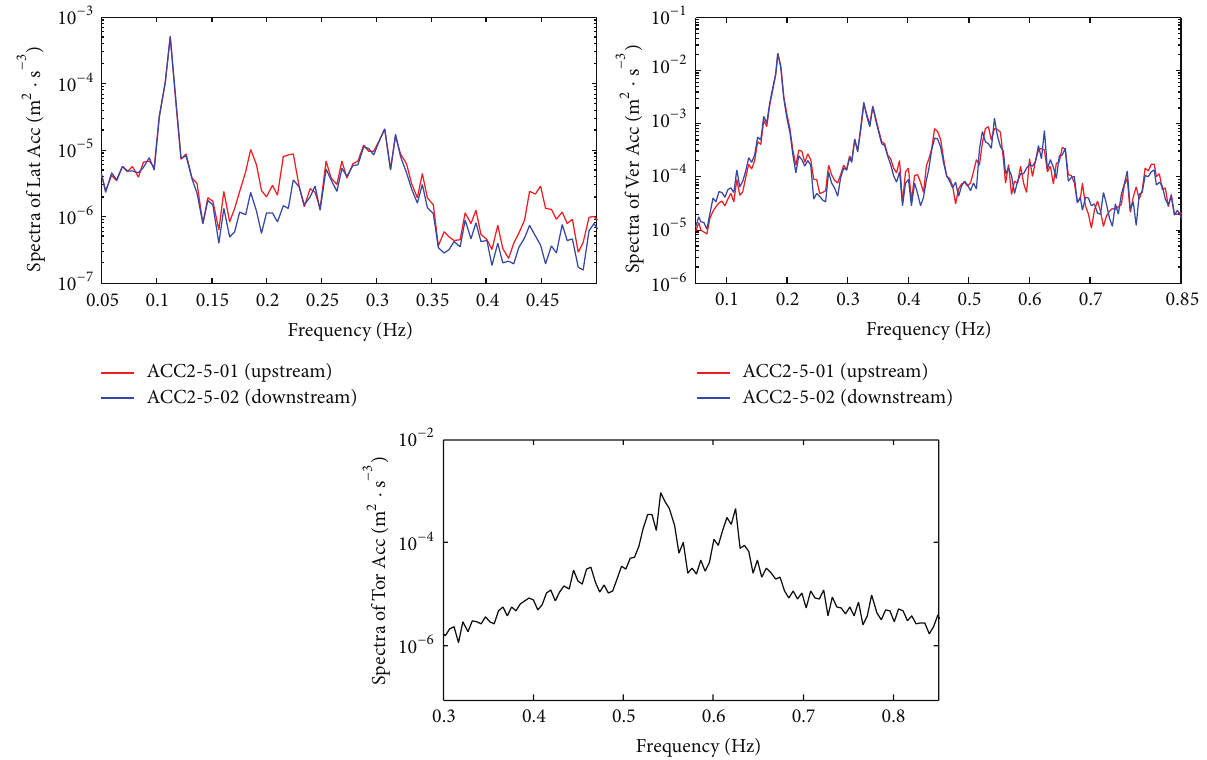
Figure 17: Spectra of deck acceleration response at the middle of the